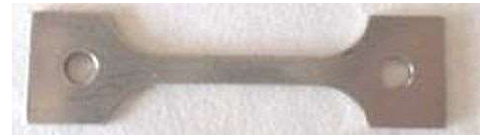
Figure 4. Small-sized flat tensile specimen.